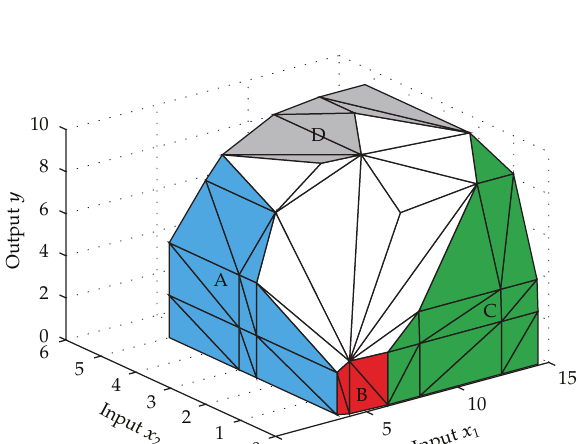
Figure 7: 2D hull.